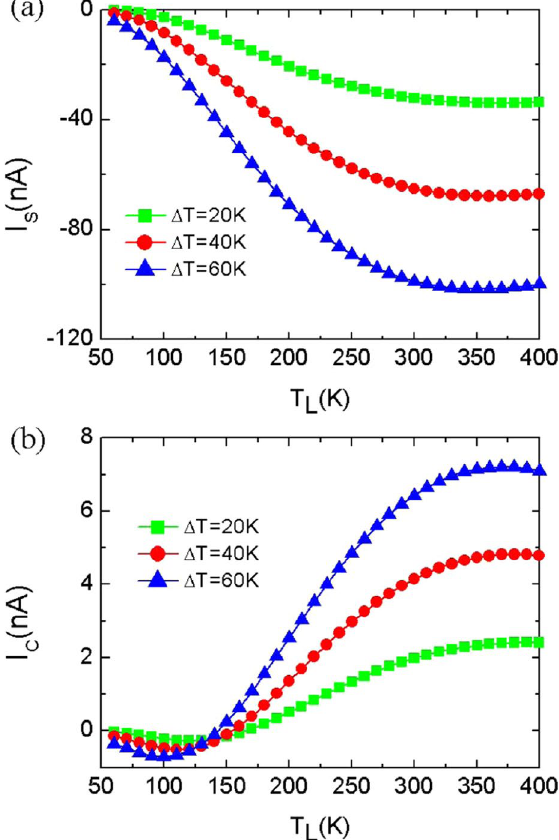
Figure 3. The total charge current and net spin current. The total charge current I C ( I up + I dn ) ( a ) and the net spin current I